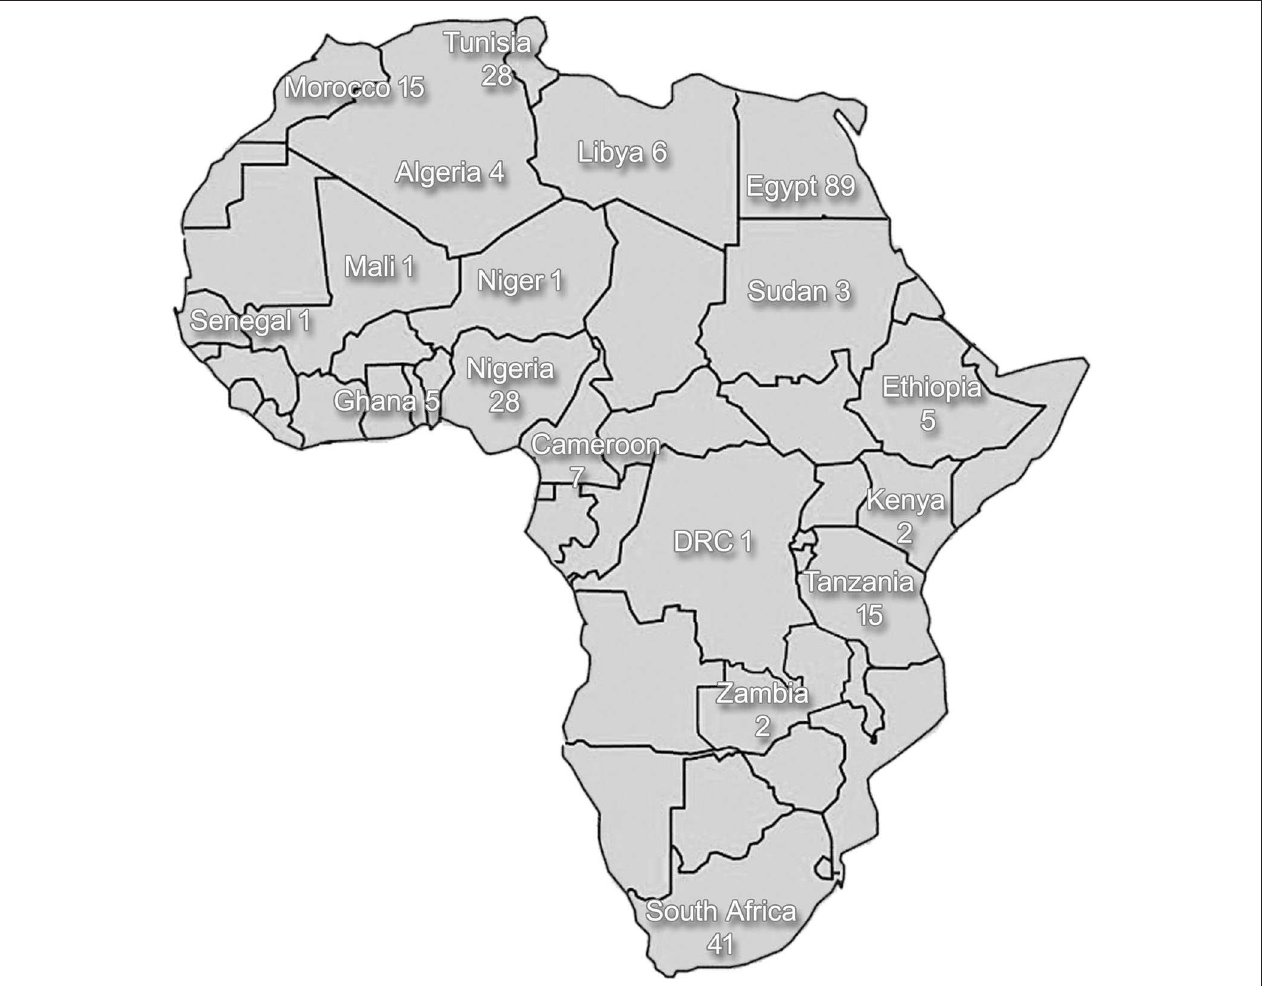
FIGURE 1 | A schematic diagram of African countries indicating the number of published articles on Parkinson’s disease per country (source: https://www.ncbi.nlm. nih.gov/pubmed/). The search was conducted in December 2019 and the term “Parkinson” was used in addition to the country name for all countries located on the African continent (Algeria-Zimbabwe); the ensuing results were then reviewed for being appropriate as a publication related to Parkinson’s disease. Duration of search extended from 2019 until